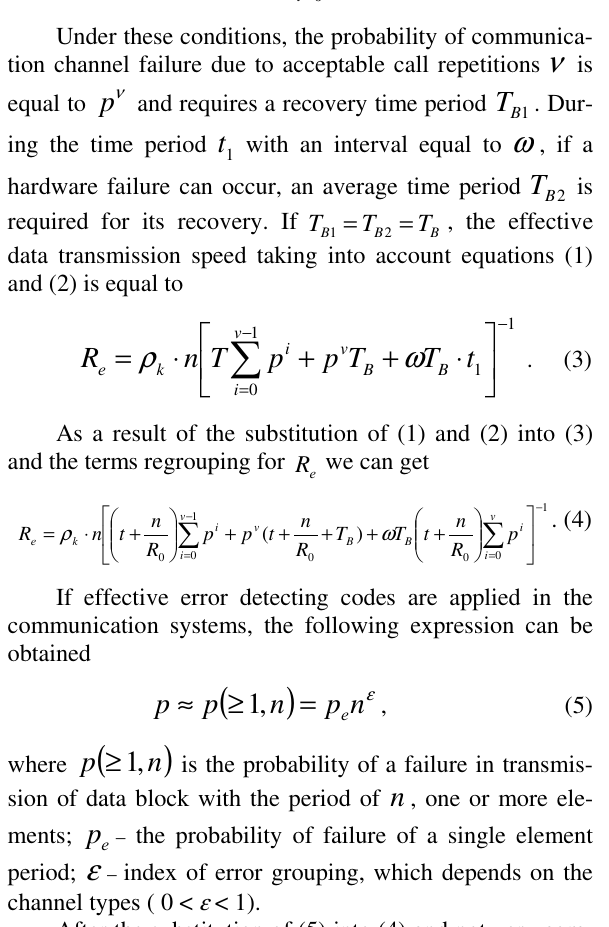
Fig 1. The relationships of R e / ρ k =